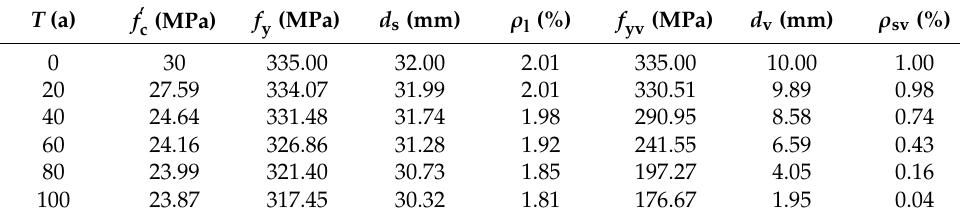
Table 5. Material parameters of bridge pier over 100 years of service.